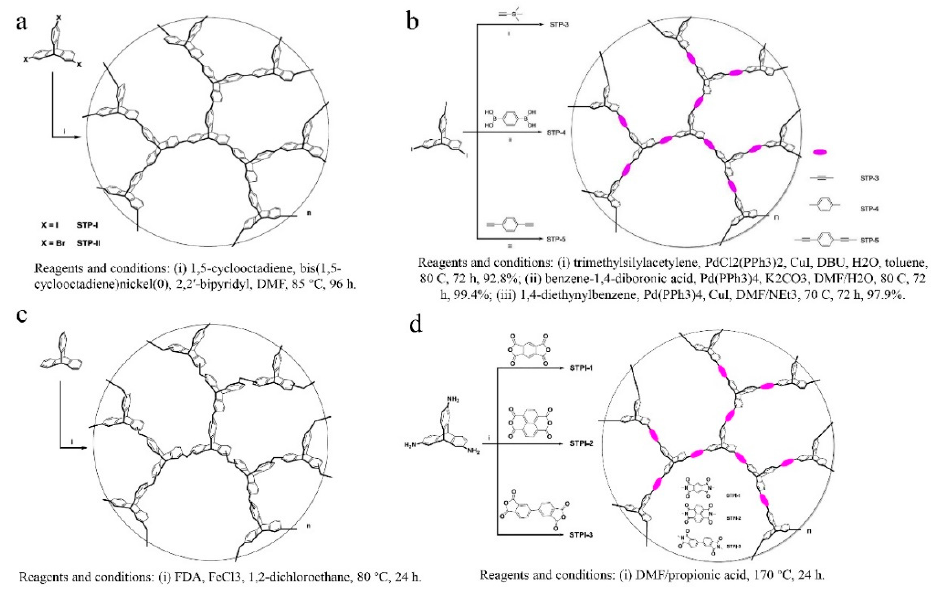
Figure 8. Synthesis of star triptycene-based porous polymers (STPs) ( a , b ), triptycene-based hyper-cross-linked polymer sponge (THPS) ( c ), star triptycene-based porous polyimides (STPIs) ( d ). Adapted from References [63–66].